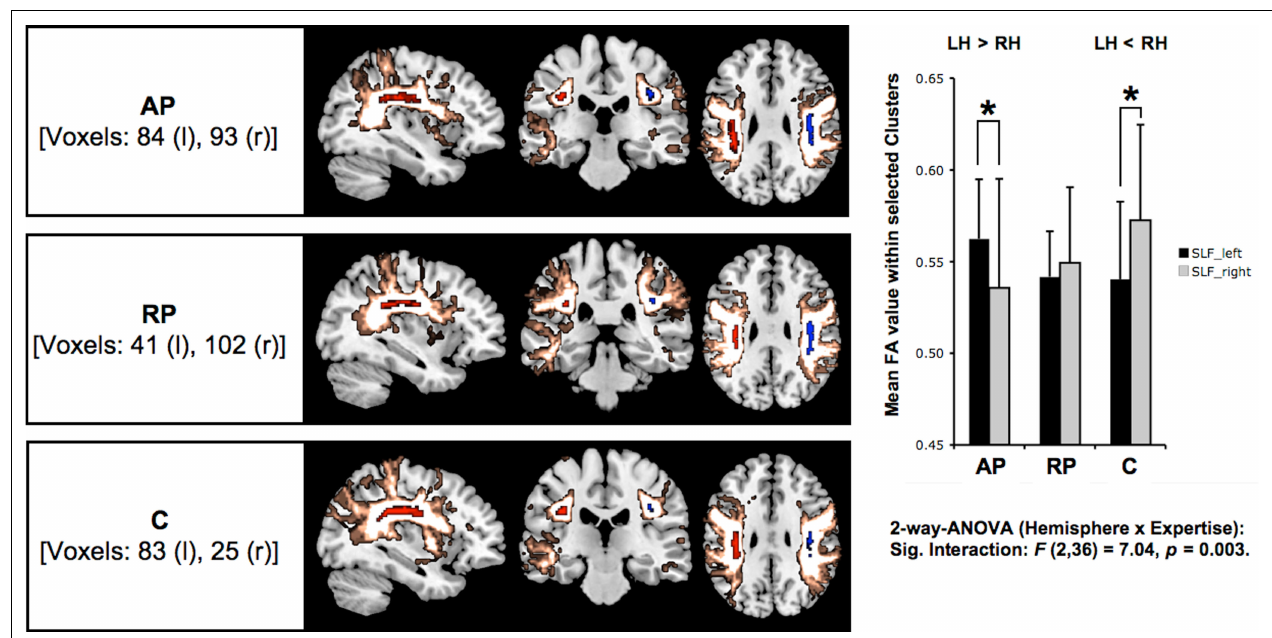
FIGURE 3 | The ROIs calculated by thresholding probability maps of bilateral SLFs’ are illustrated in red (left) and blue (right), surrounded by unthresholded group specifi c probability maps (gold). The bar chart illustrates for each group and both hemispheres the standard deviation (error bars) and means of FA values calculated by comprising